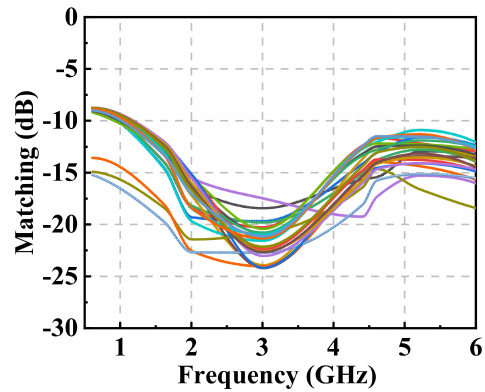
Figure 11. The matching in different channels for the input and output for the COB with bond- ing wires.